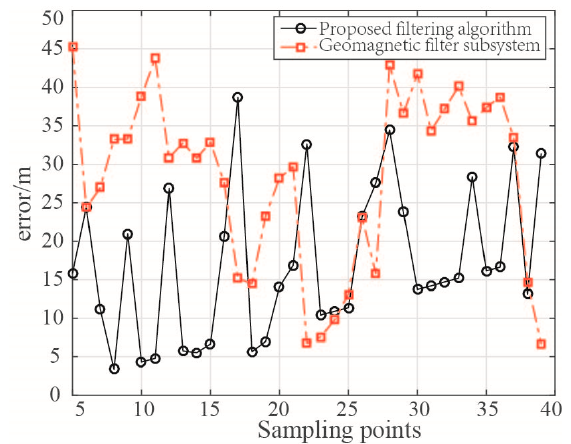
Figure 15. Filtering result in flight experiment.